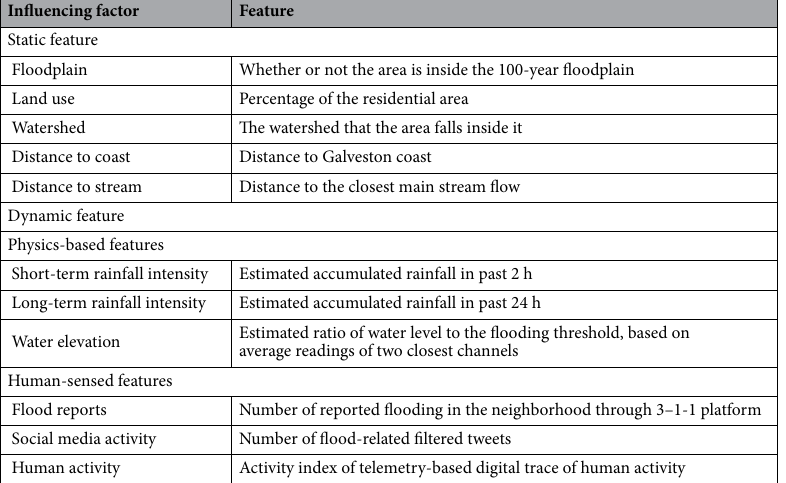
Table 1. Static and dynamic features used for urban flood